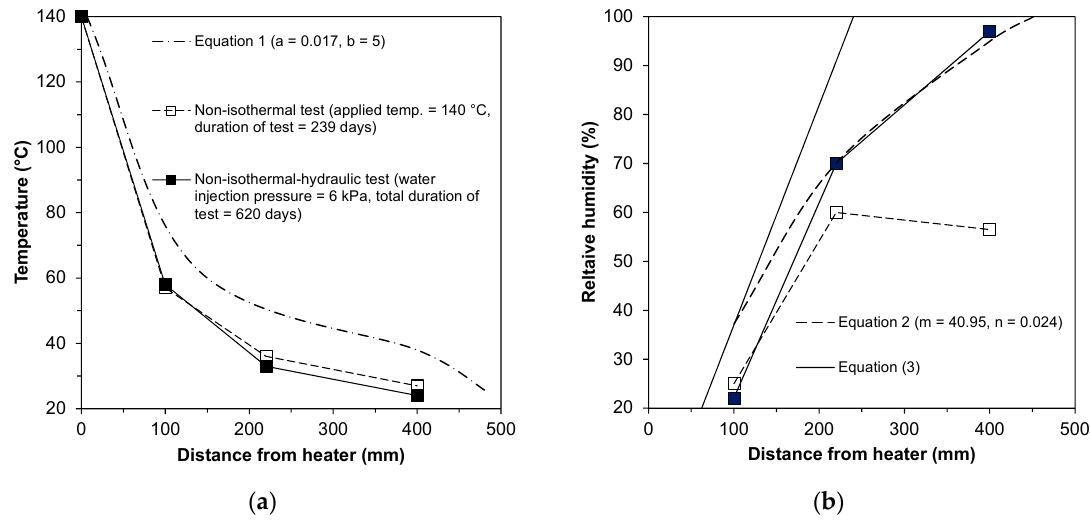
Figure 13. Comparison of test results from the literature [17] and model results in this study for: ( a ) temperature profiles; ( b ) relative humidity profiles.